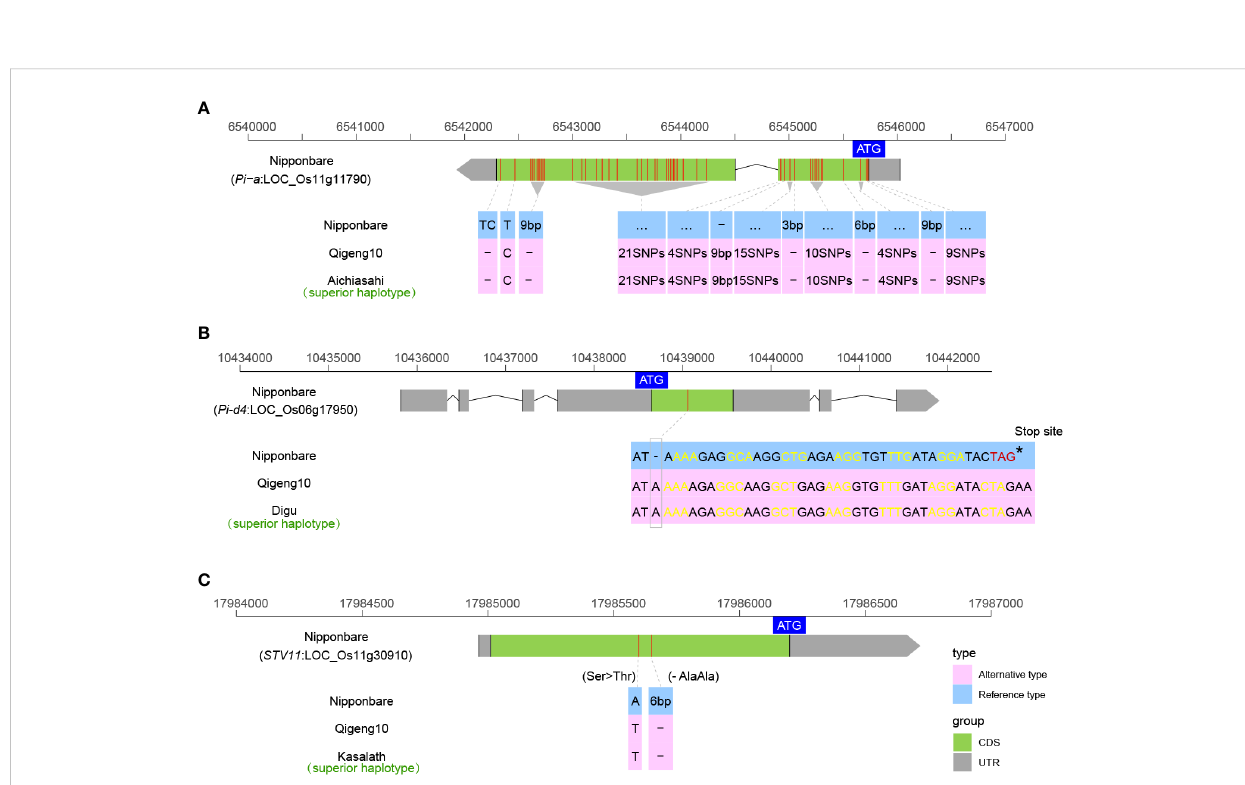
FIGURE 6 The allelic information of sequence variants in Pia (A) , Pid4 (B) , and STV11 (C) controlling disease resistance in